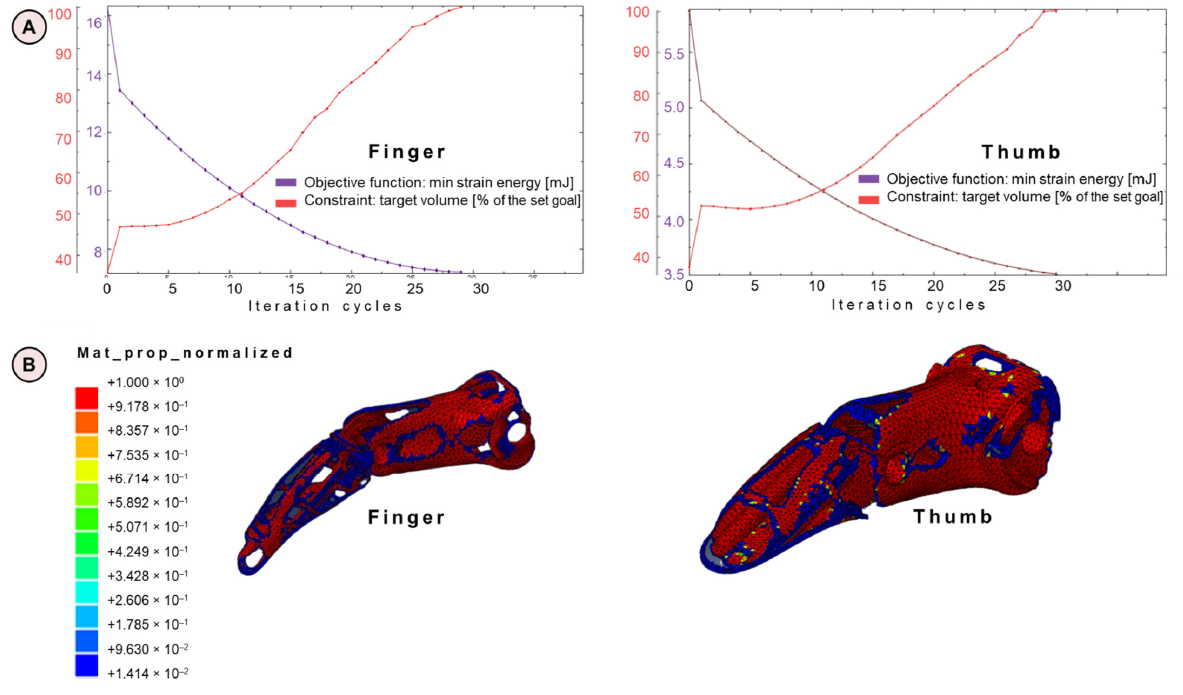
Figure 8. ( A ) Topology optimization graphs for the obsolete finger (left) and the obsolete thumb (right), reporting both the objective function and the constraint; ( B ) map of the relative density (mat_prop_normalized) for finger and thumb optimization. Blue regions are identified as possible removal sites, in contrast with red zones.